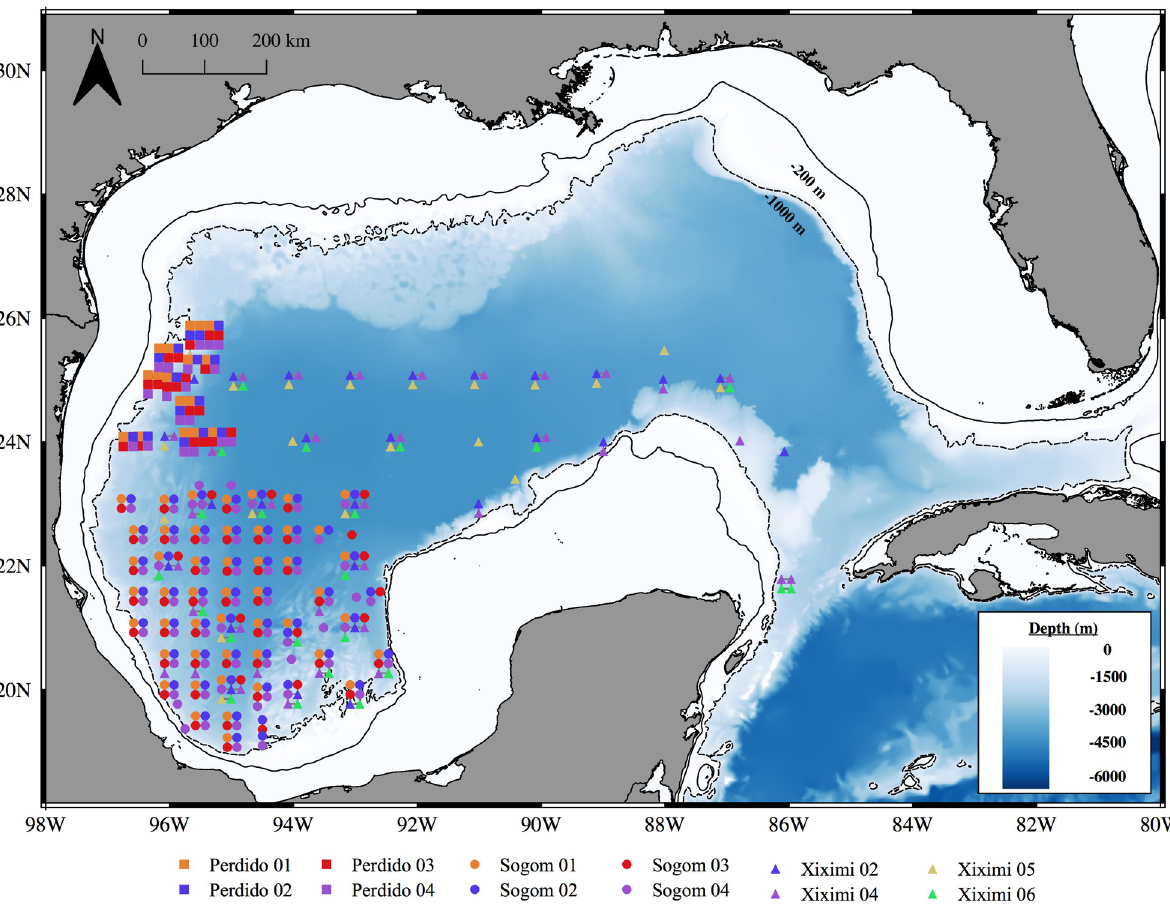
Fig 1. Ichthyoplankton sampling stations covered during cruises held between 2011–2018 in the southern Gulf of Mexico. PERDIDO (squares), SOGOM (circles) and XIXIMI (triangles) cruises. To allow for the visualization of multiple samples collected at a given station, their location is represented as a grid. Yucatan Channel stations were only sampled in season II. Continuous and dashed lines represent the 200 m and the 1000 m isobaths,